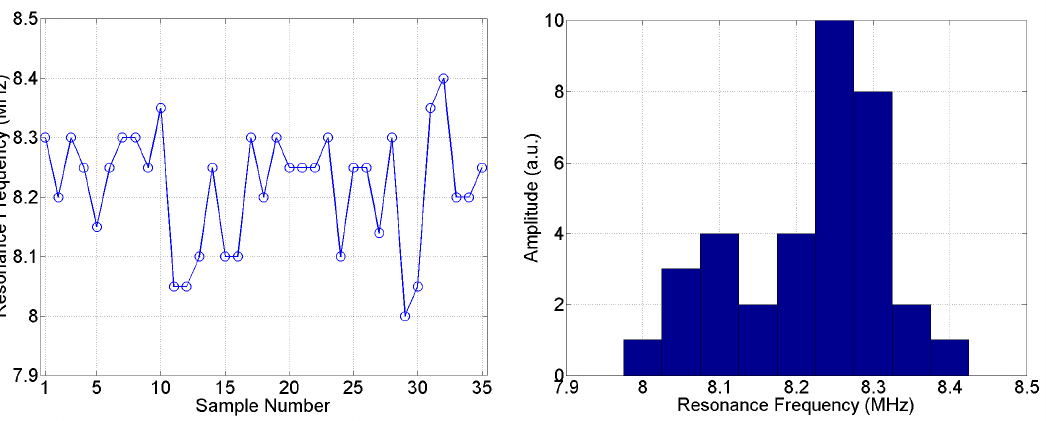
Figure 10. Plot (left) and histogram (right) showing the resonance frequency of 35 manufactured interdigital EAS tags as measured after the application of the screen print silver paste on the opposite side of the interdigital capacitor, without any adjustment of the